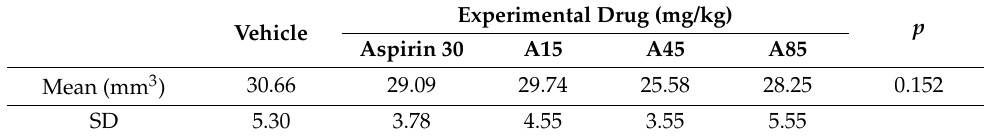
Table 5. Effects of Sample A on infarct volume after pMCAO ( n = 8–10 mice for each group).